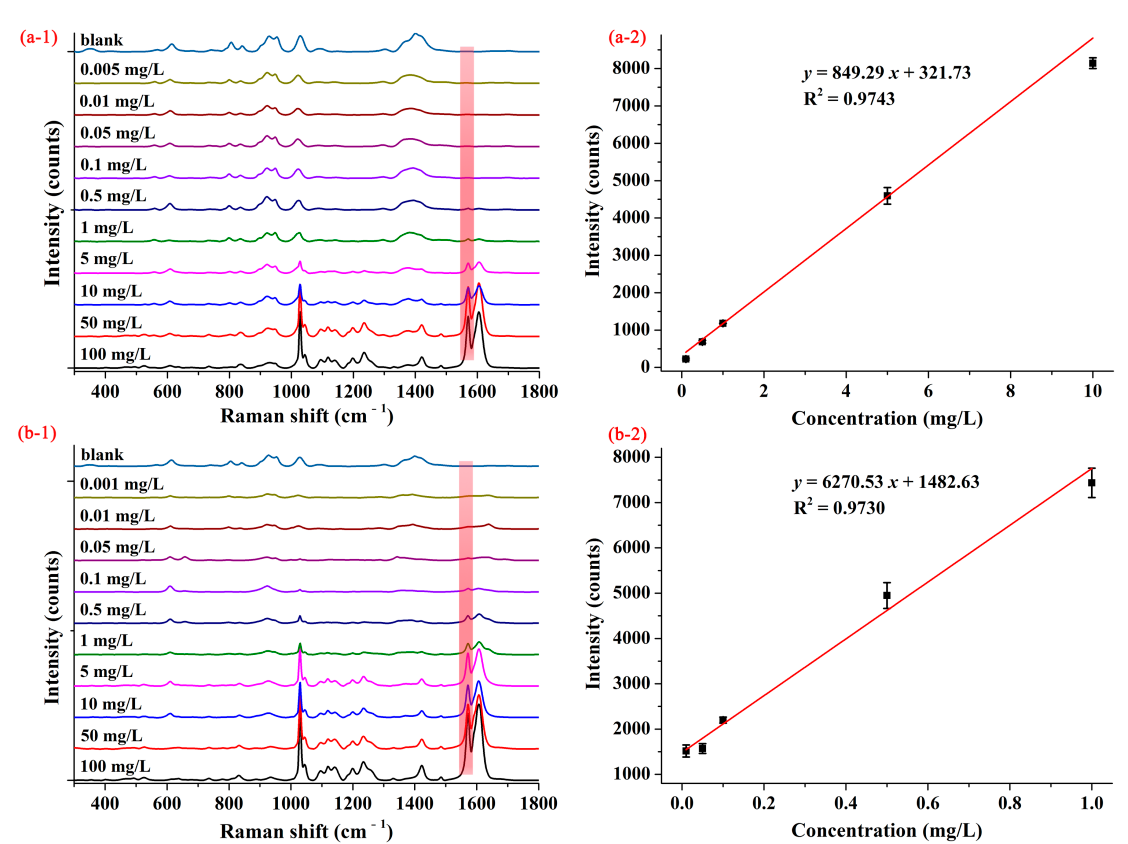
Figure 3. The average SERS spectra ( 1 ) and concentration-dependent intensity at 1572 cm − 1 ( 2 ) of pymetrozine based on ( a ) AgNPs and ( b ) decanethiol M-AgNPs.